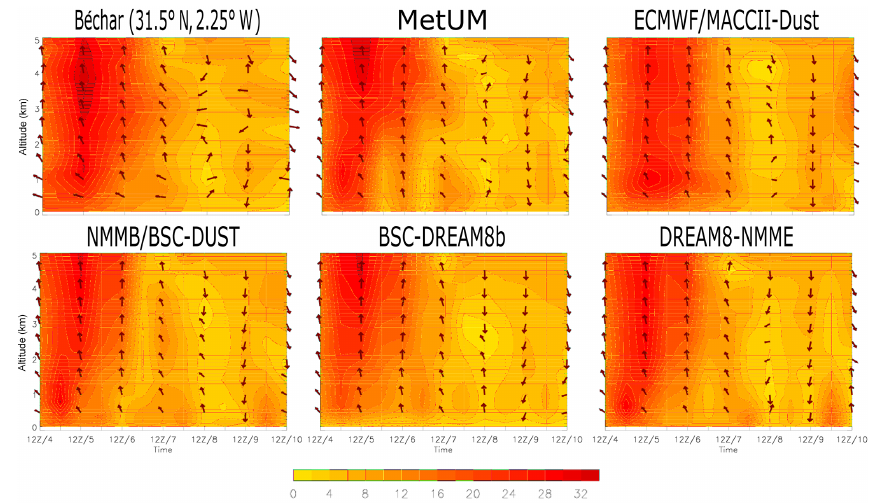
Figure 11. Profiles of measured wind speed (ms − 1 , filled contours) and direction (vectors, first column) between 4 and 10 April from radio sounding at Béchar (31.5 ◦ N, 2.25 ◦ W; first row) and the corresponding 24h forecasts of models MetUM, ECMWF/MACC, NMMB/BSC- DUST, BSC-DREAM8b and